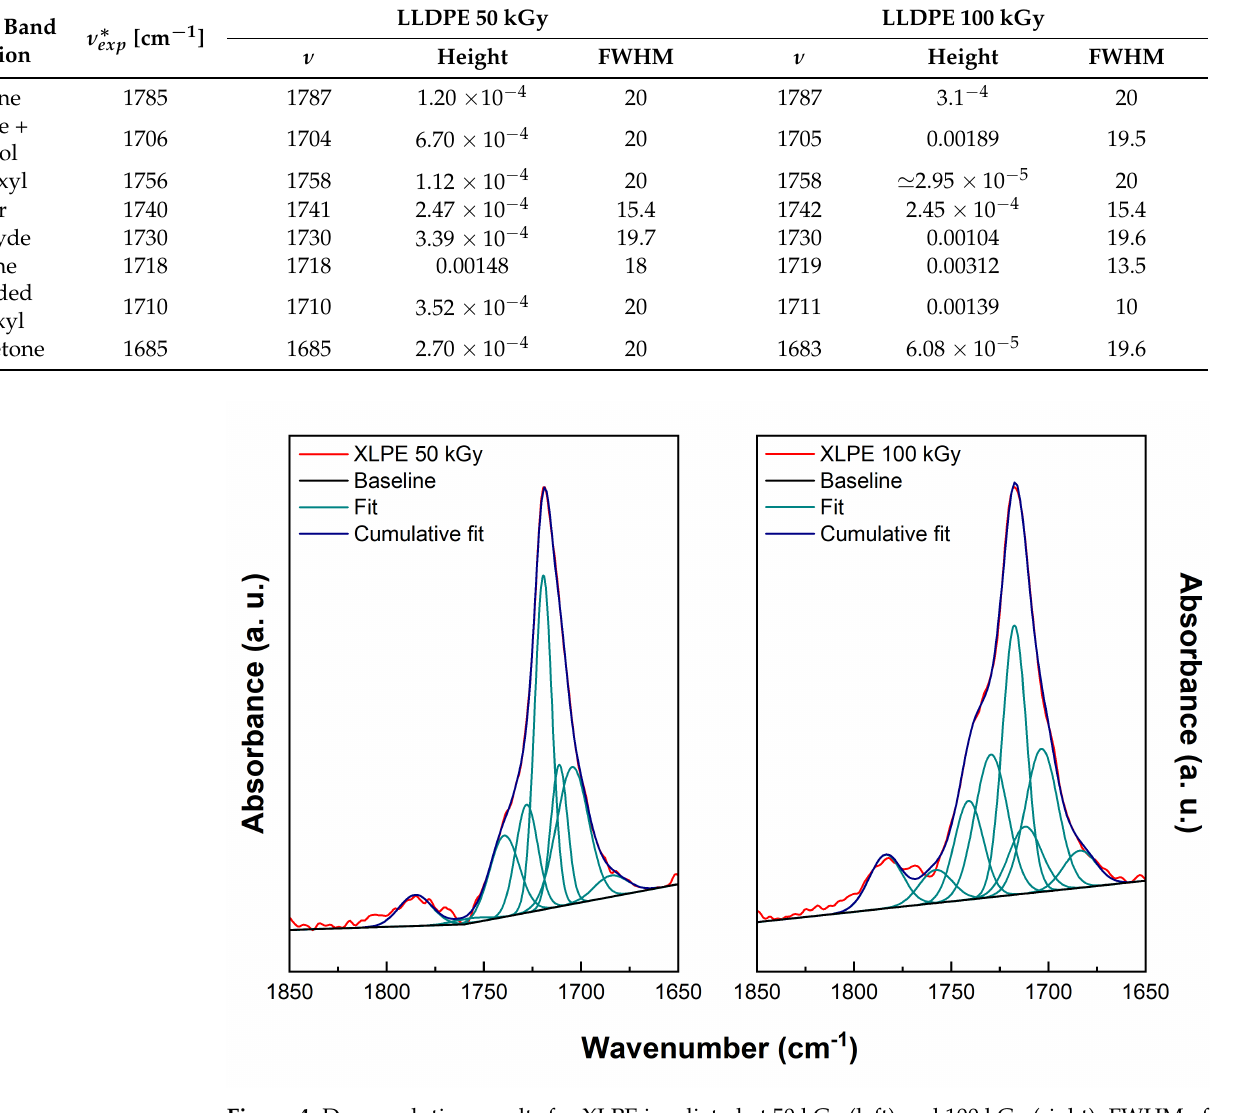
Figure 4. Deconvolution results for XLPE irradiated at 50 kGy (left) and 100 kGy (right). FWHM of the fitting Gaussians are constrained between 10 and 20 cm − 1 . Associated numerical results are given in Table